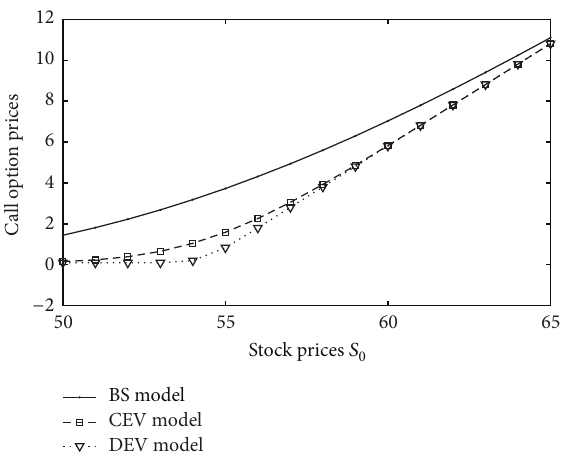
Figure 11: Call option prices at 𝐾 = 53 during subprime crisis.